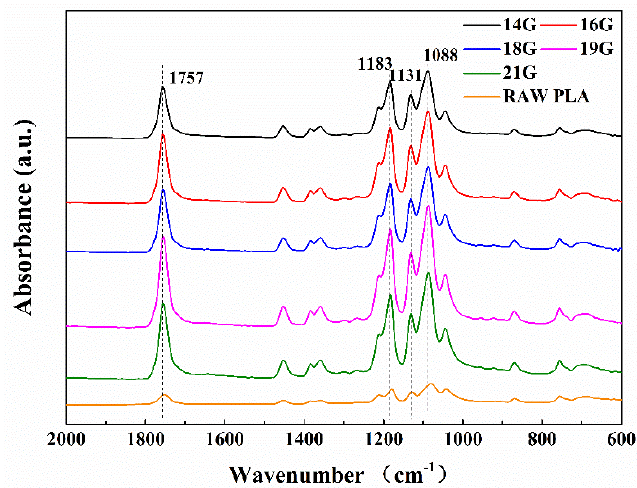
Figure 7. The ATR-FTIR spectra of samples prepared by 14 G, 16 G, 18 G, 19 G, 21 G needles and the raw PLA.